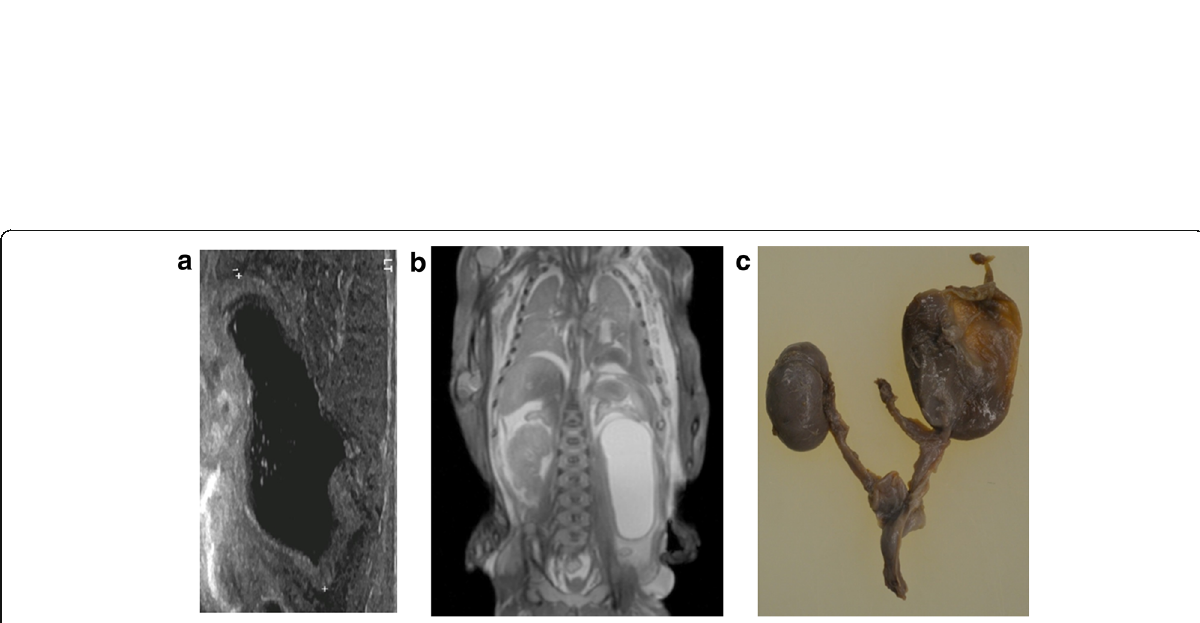
Fig. 16 Unilateral left renal outflow obstruction from pelviureteric junction obstruction (PUJO) in a foetus at 21 weeks gestation, after termination of pregnancy. Post-mortem imaging was performed 10 days after delivery. The sagittal post-mortem ultrasound image of the left kidney ( a ) demonstrates a dilated renal pelvis, with only a thin rind of renal cortex stretched around the pelvis. The same finding is shown on the post- mortem T2-weighted MRI image in coronal plane ( b ), and a normal right kidney is demonstrated. A photograph of the extracted kidneys and ureters at autopsy ( c ) confirm the imaging findings of a much larger and dilated left kidney, with normal right